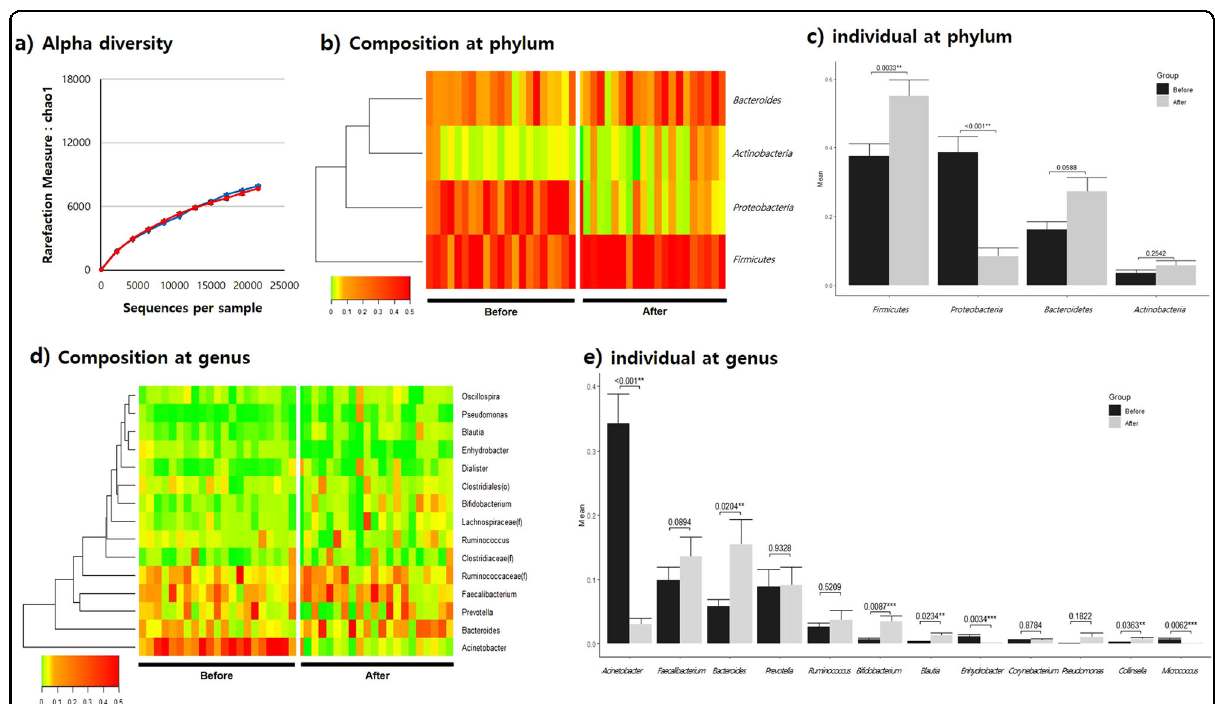
Fig. 2 Composition of microbiota-derived stool EVs before and after consumption of a synbiotic beverage. a Alpha diversity measured by Chao1, b composition of the microbiome at the phylum level, c individual the microbiome at the phylum level, d composition of the microbiome at the genus level, and e individual microbiome at the genus